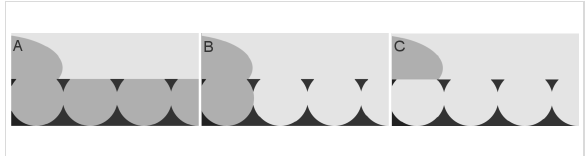
Figure 1: Schematic representation of the three wetting states on an inverse opal, A) impregnated state, B) Wenzel state, C) Cassie–Baxter state.